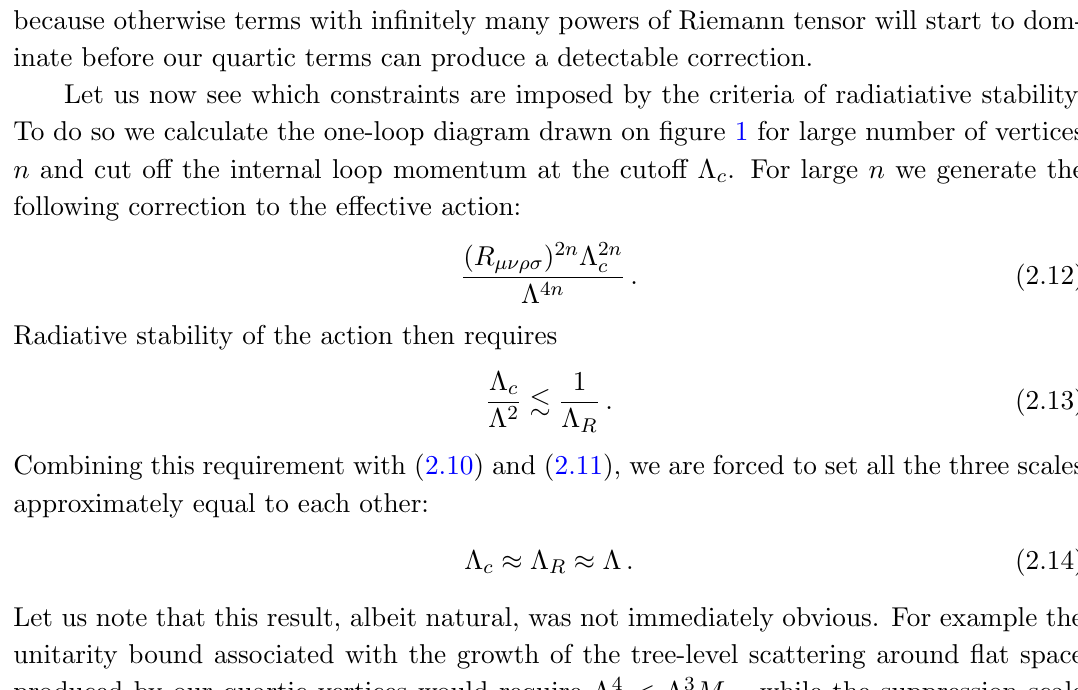
operator, in this case R (cid:22)(cid:23)(cid:26)(cid:27) 8 , through (cid:22)(cid:23)(cid:26)(cid:27)